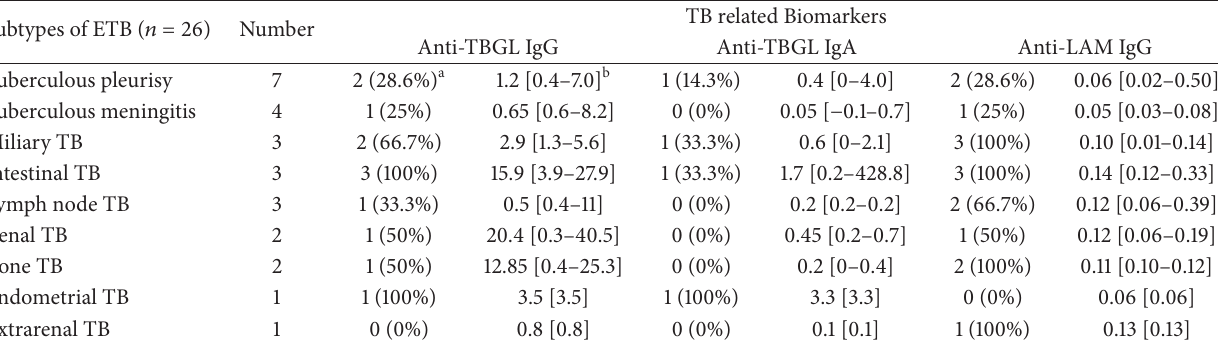
Table 2: Anti-TBGL IgG, anti-TBGL IgA, and anti-LAM IgG in ETB